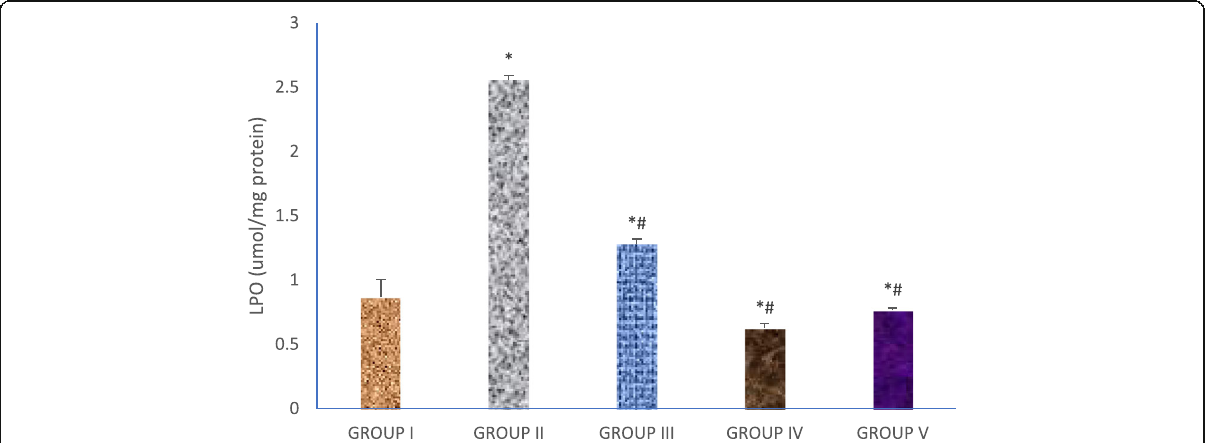
Fig. 7 Effect of MLVA on testicular lipid peroxidation (LPO) of rats treated with nitrobenzene. Data are given as mean ± SD of rats per group. n = 6. MLVA: methanolic leaf extract of Vernonia amygdalina , *: Values differ significantly from group I (control) ( P < 0.05). #: Values differ significantly from group II